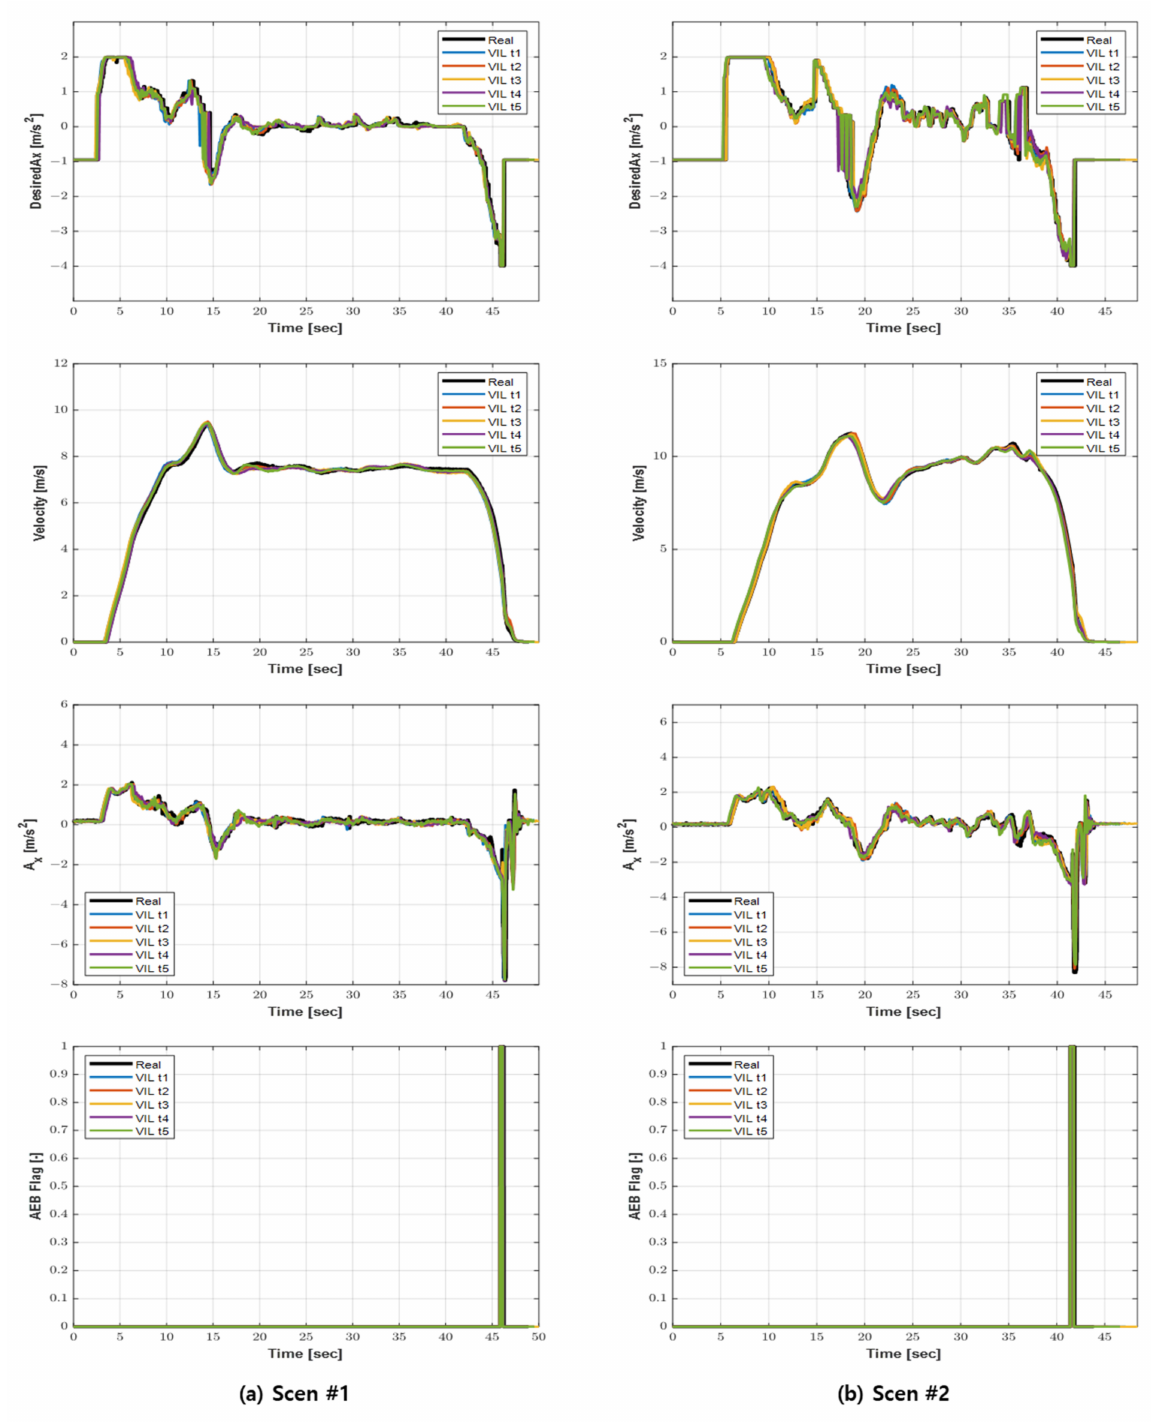
Figure 18. Result of Longitudinal behavior